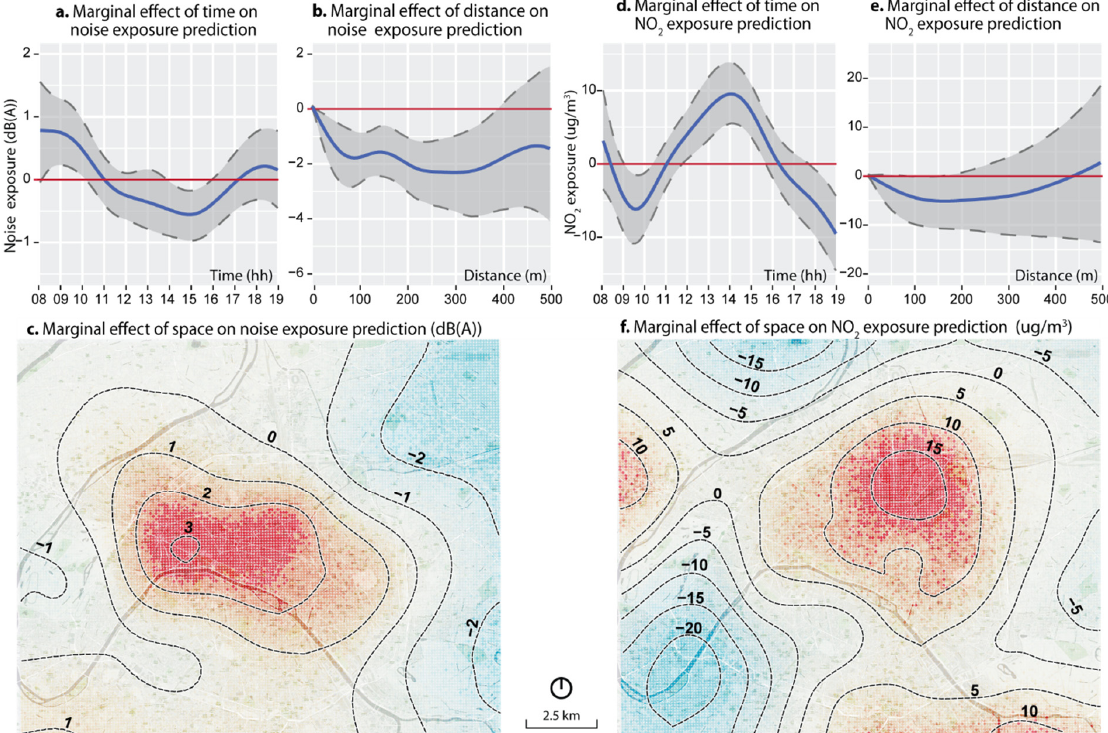
Figure 5. Marginal effects of model’s nonlinear terms. Note: These maps show the splines on the geographic coordinates introduced in the model. They do not represent a concentration map for the NO 2 or noise. These spatial and temporal trends are valid only for the data collection period; they cannot be generalized over the whole year. ( a ) Marginal effect of time on noise exposure prediction; ( b ) Marginal effect of distance on noise exposure prediction; ( c ) Marginal effect of space on noise exposure prediction (dB(A)) ( d ) Marginal effect of time on NO 2 exposure prediction; ( e ) Marginal effect of distance on NO 2 exposure prediction; ( f ) Marginal effect of space on NO 2 exposure prediction (µg/m 3 ).